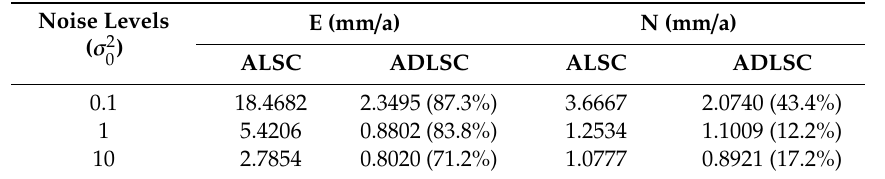
Table 5. The signal variance estimated results by the first Helmert VCEM calculation of the two algorithms under different noise levels.